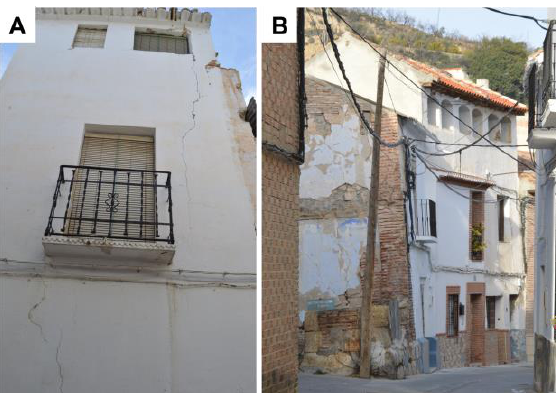
Figure 4. Buildings of the Albuñuelas village affected by slight deformations ( A ) and tilting ( B ) due to the activity of a deep-seated landslide on which the village is located.